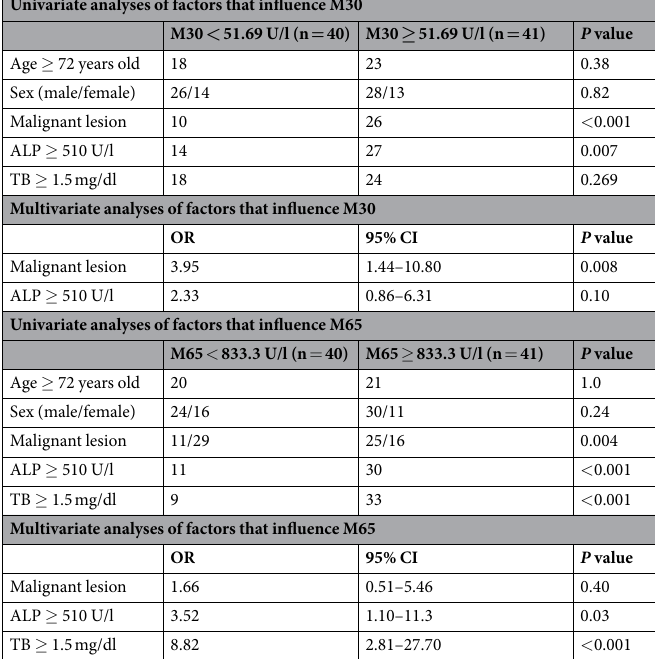
Univariate analyses of factors that influence M30